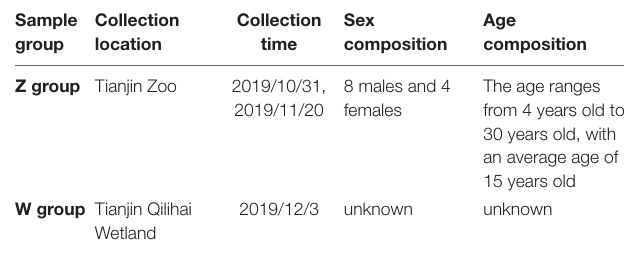
TABLE 1 | Basic information on experimental